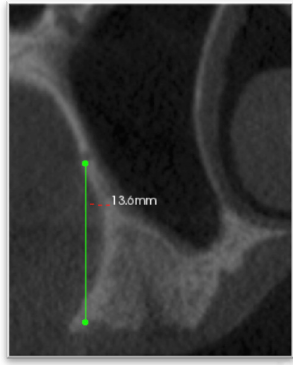
Fig. 4. Distance between the lower border of the artery and alveolar crest.